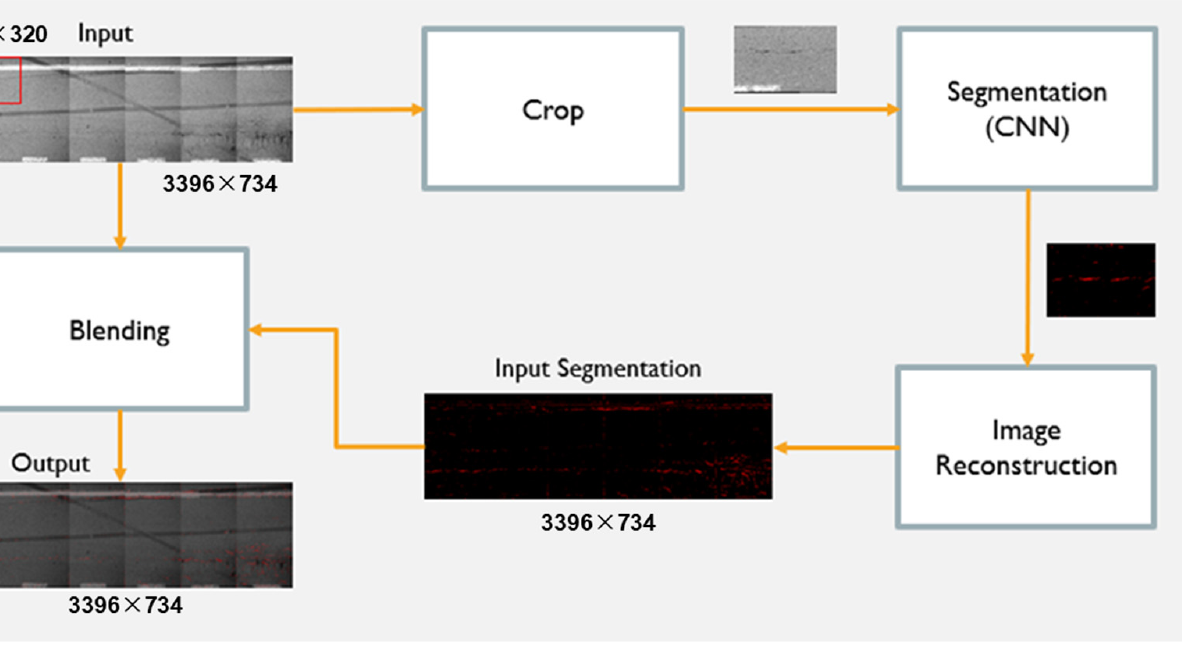
Figure 12. Illustration of the U-Net architecture proposed in [24]. In Figures 13–15, it is possible to observe a road lane section, the corresponding seg- mentation, and the merging of the two previous images, respectively. Figure 13. Sample of a road lane section.